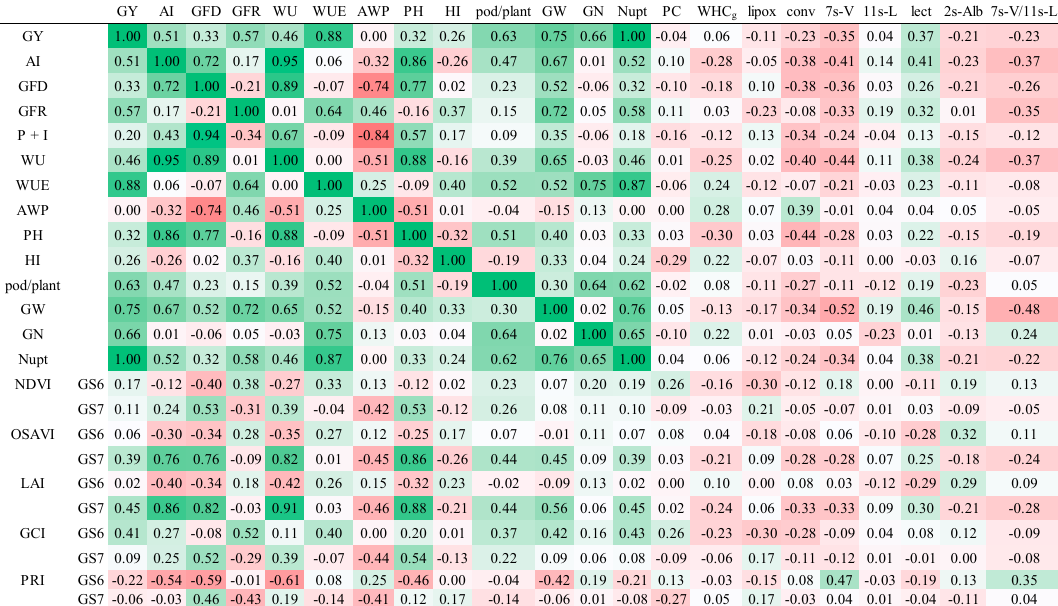
Figure 4. ( a ) Relationship between PRI, measured at grain filling, and water supply (rainfall and irrigation), and ( b ) with grain filling rate; ( c ) relationship between GCI, measured at flowering, with grain filling rate (GFR); ( d ) relationship between OSAVI, measured at grain filling, with grain yield. Chickpea genotypes Pascià and Sultano are reported in deep grey and light grey, respectively.